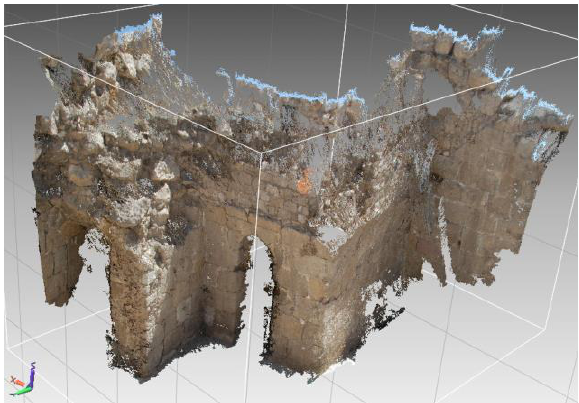
Figure 14. The point clouds obtained by the algorithm, at the upper level of Tower